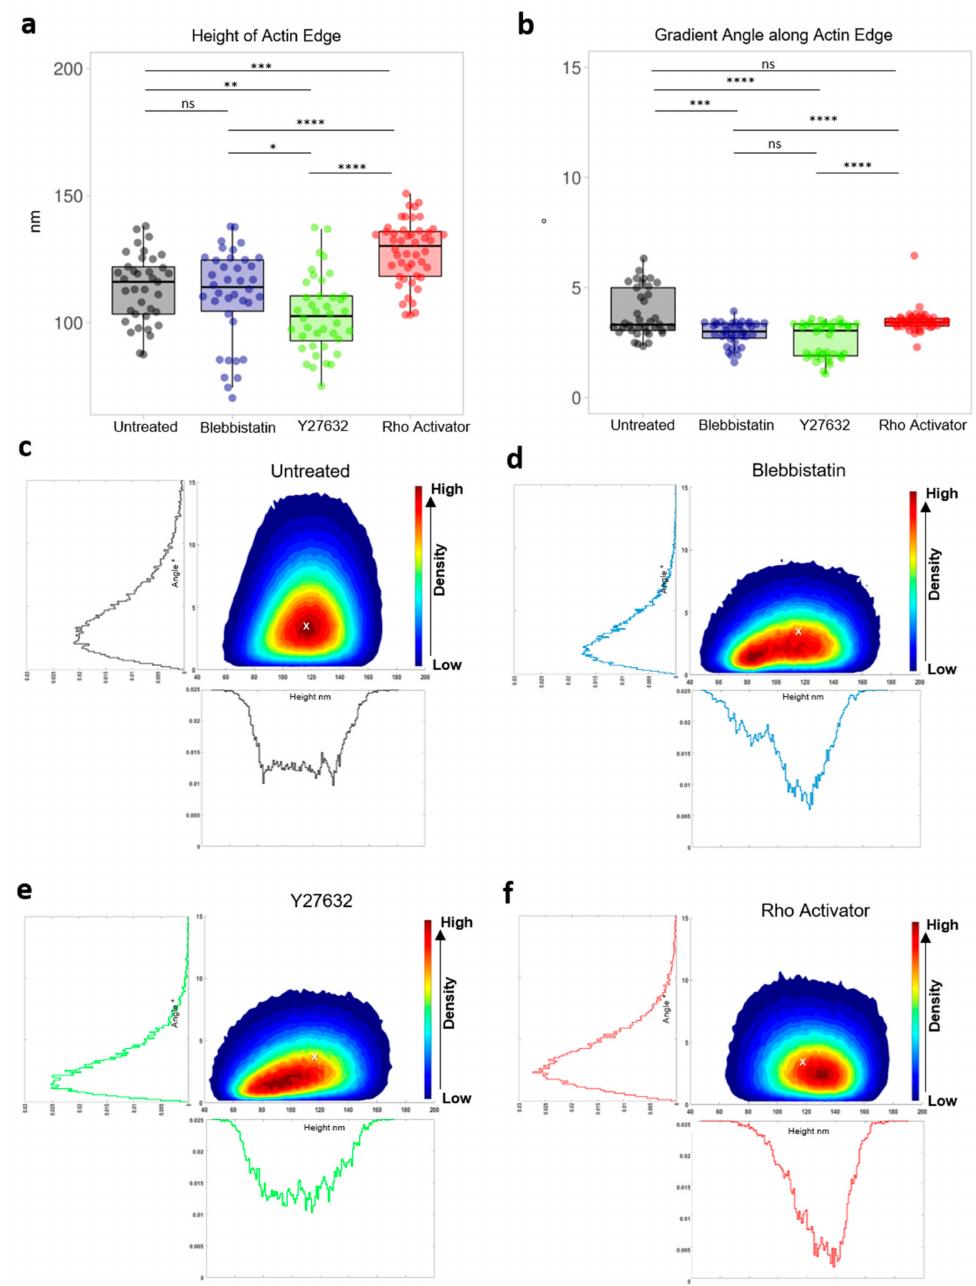
Figure 5. Actin edge analysis. ( a ) Height of actin edge of untreated and blebbistatin, Y27632, Rho Activator treated cells. Each dot represents the median of a single cell. ( b ) Gradient angle along actin edge of untreated cells and cells treated with blebbistatin, Y27632 and Rho activator. Each dot represents the median of a single cell. Test: Kruskal-Wallis and post hoc Dunn’s test. ns: p > 0.05, *: p ≤ 0.05, **: p ≤ 0.01, ***: p ≤ 0.001, ****: p ≤ 0.0001. Contour of the scatter plot of the height of actin edge and the gradient angle along actin edge. The colormap indicates the density. Histogram of the gradient angle along the actin edge and histogram of the height of actin edge. ( c ) Untreated cells. ( d ) Rho-activator treated cells. ( e ) Blebbistatin-treated cells. ( f ) Y27632 treated cells. The white cross in Plot ( c – f ) shows the maximum of the untreated cell. Table 1 provides a summary (median ± std) of the analysis of the actin cytoskeleton in z dimension using MIET, as well as the gradient angles along the actin